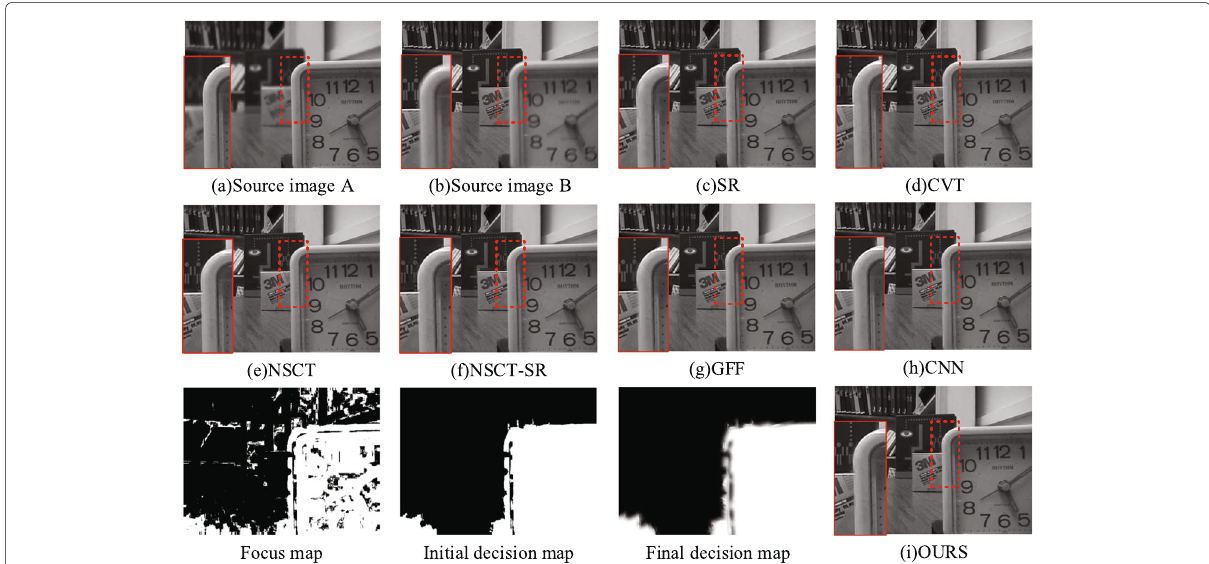
Fig. 7 Fusion results of “Disk” source images. Fusion results of different methods of “Disk” source images are presented. The border area of each fused image between focused and non-focused is displayed in the lower left corner to clearly distinguish the difference. Intermediate fusion results of our methods are shown as focus map and decision map